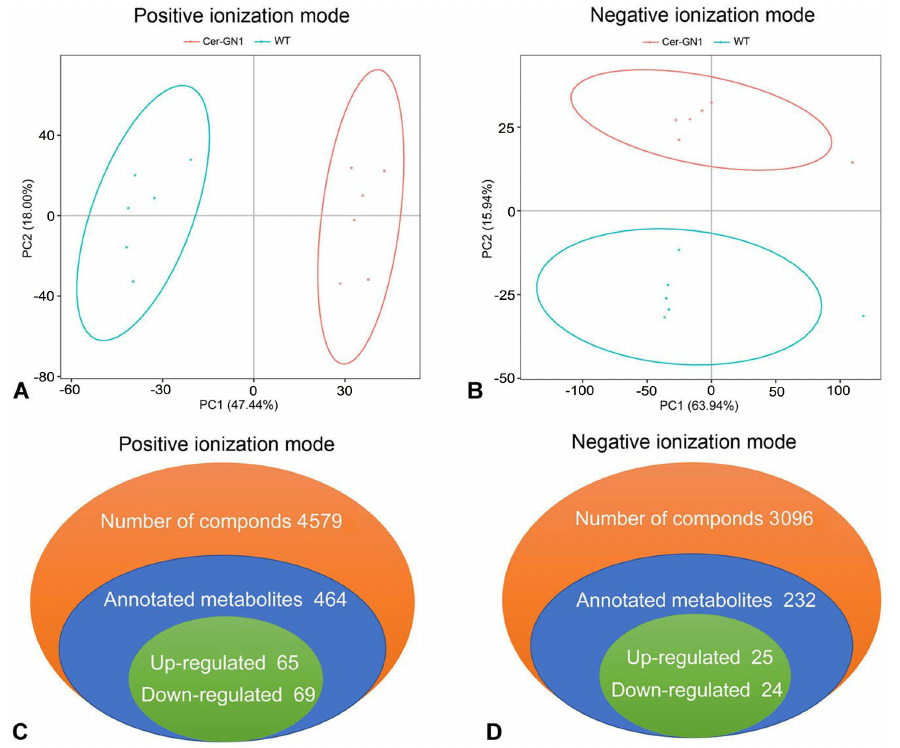
Figure 3. Metabolite properties of the glumes in Cer-GN1 mutant and WT plants. Overall score plots of the PCA model in the positive ( A ) and negative ( B ) ionization modes, respectively. Summary of the metabolomics quantified in the positive ( C ) and negative ( D ) ionization modes, respectively.